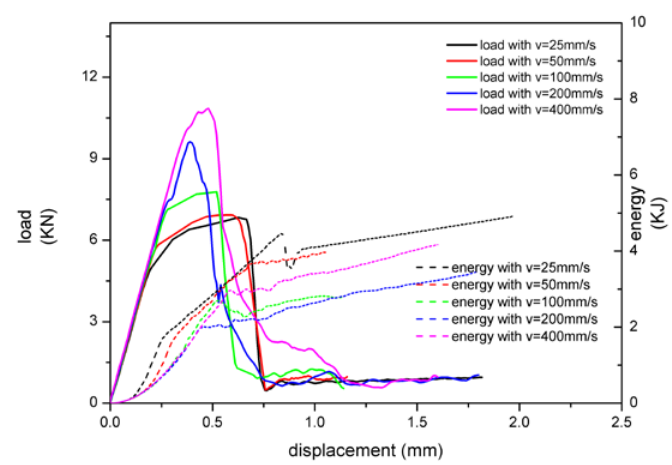
Figure 6. The relationship between load, energy absorption, and displacement with tiebreak contact.